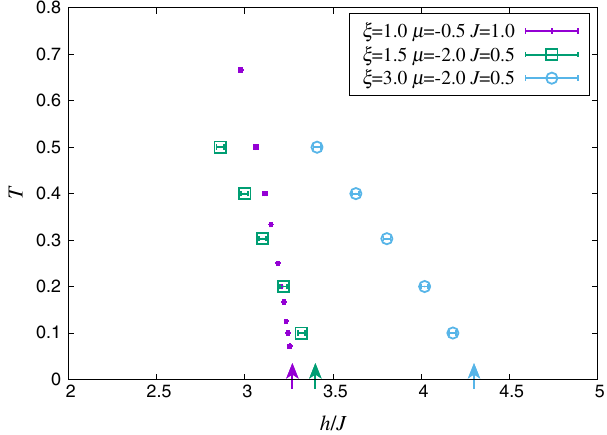
FIG. 4. Estimation of the FM QCP for larger coupling. There are three parameter sets in total: f ξ ¼ 1 . 0 ; μ ¼ − 0 . 5 ; J ¼ 1 . 0 g , f ξ ¼ 1 . 5 ; μ ¼ − 2 ; J ¼ 0 . 5 g , and f ξ ¼ 3 . 0 ; μ ¼ − 2 ; J ¼ 0 . 5 g . The finite-temperature phase boundaries are determined from the Ising spin susceptibilities, as discussed in Appendix D. The QCPs are denoted by the colored arrows. Close to each FM QCP, we scan h to measure various superconductivity instabilities. The results are shown in Fig.